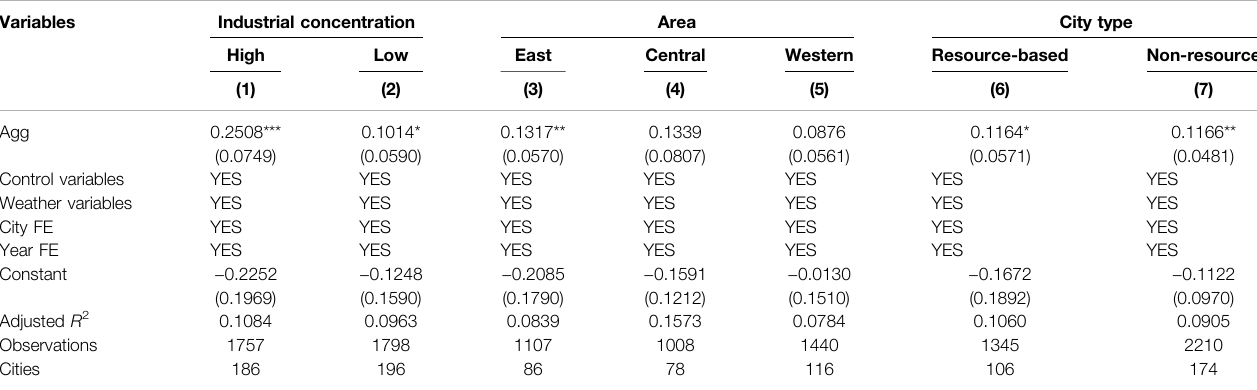
TABLE 5 | Heterogeneity